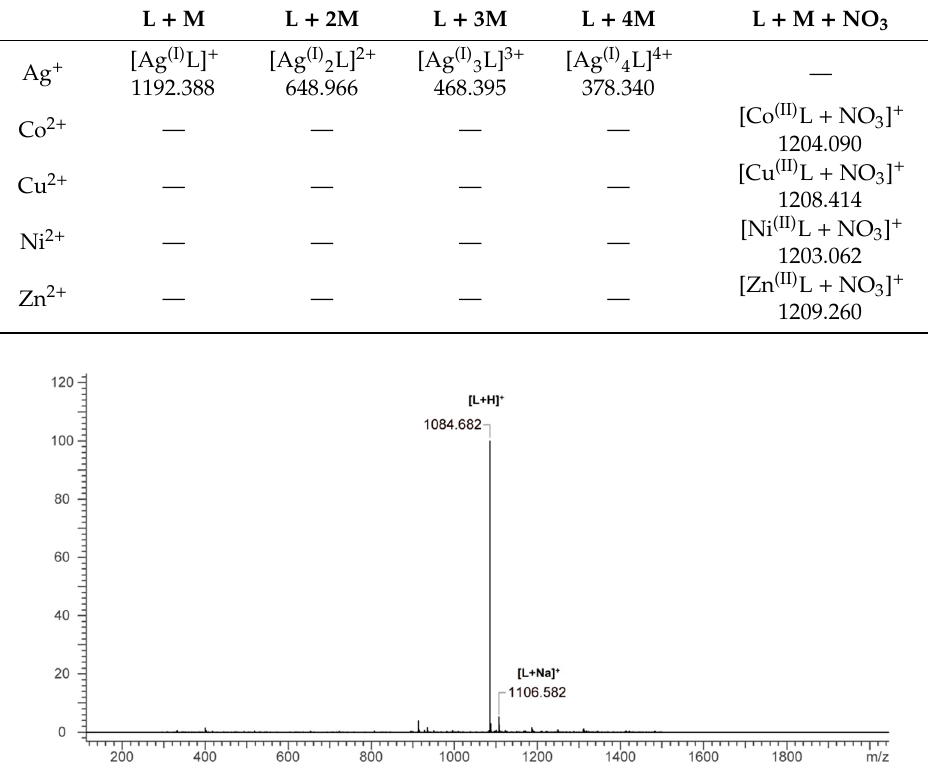
Table 2. Complexes confirmed by electrospray mass spectrometry and tandem mass spectrometry methods (ESI-MS / MS).